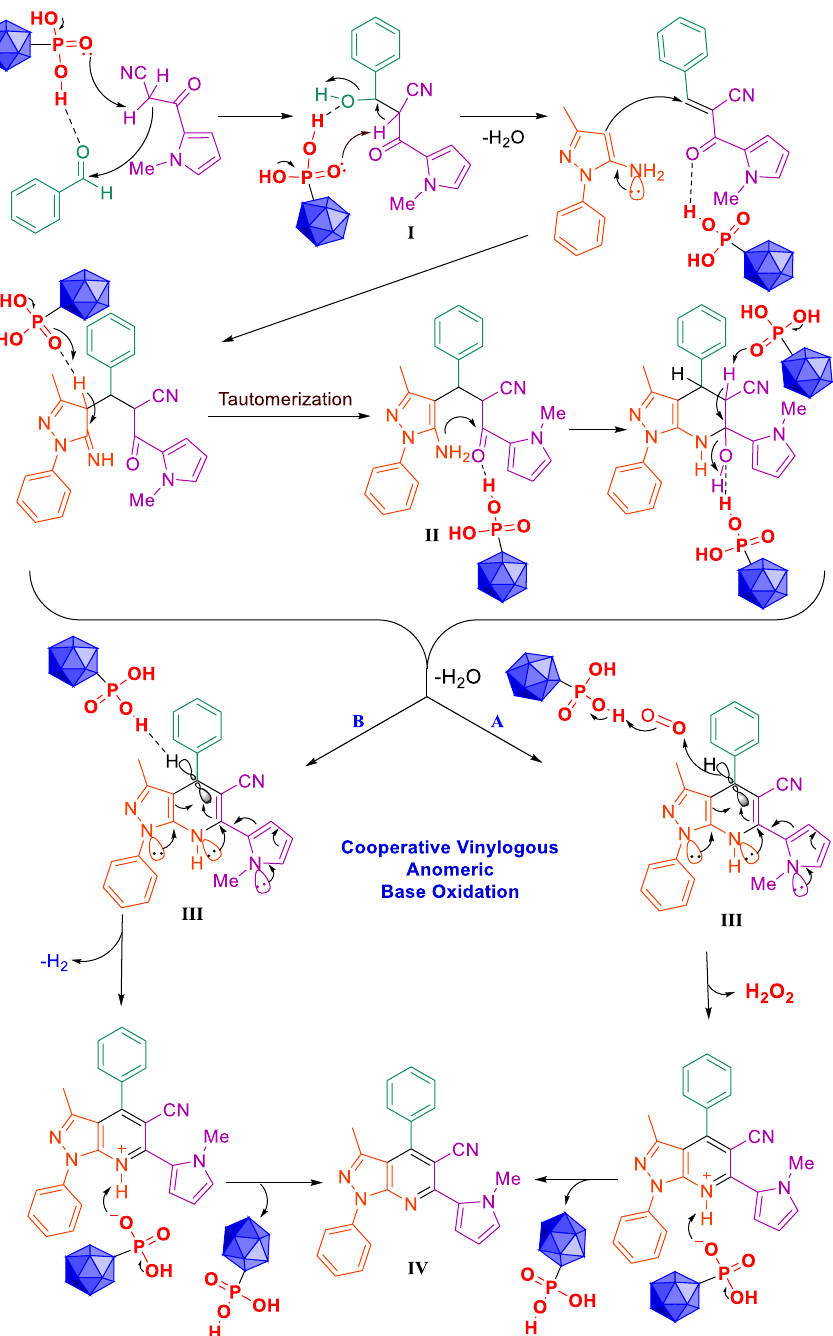
Figure 14. Plausible mechanisms for the synthesis ( N -methyl-pyrrol)-pyrazolo[3,4- b ]pyridines using MIL- 53(Al)-N(CH 2 PO 3 H 2 ) 2